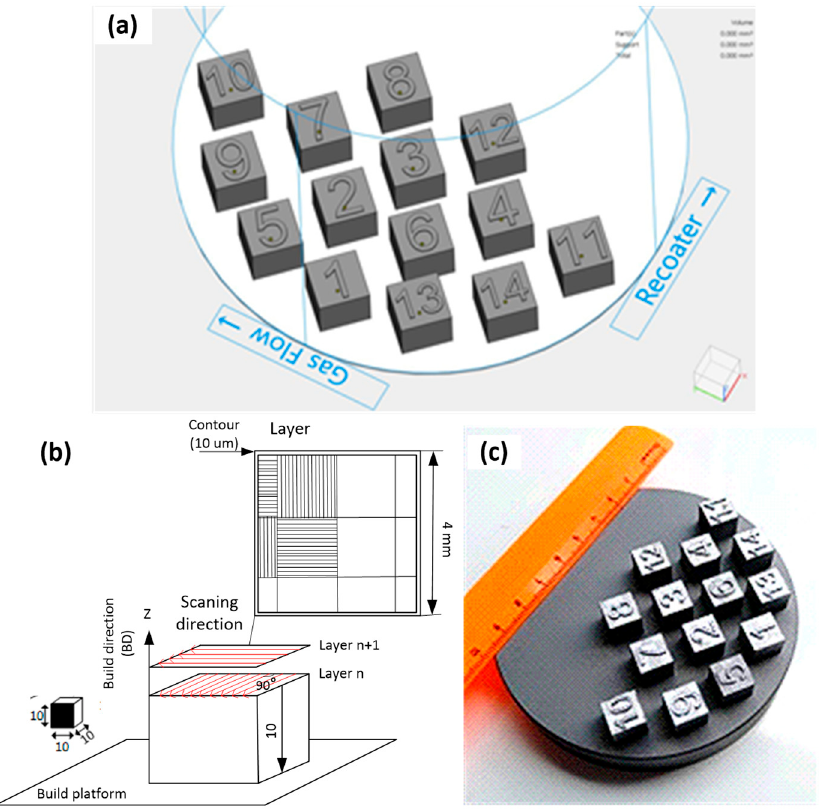
Figure 2. ( a ) Schematic presentation of the specimens on the build plate, ( b ) LPBF scanning strategy (dimensions in mm) and ( c ) result of the build.